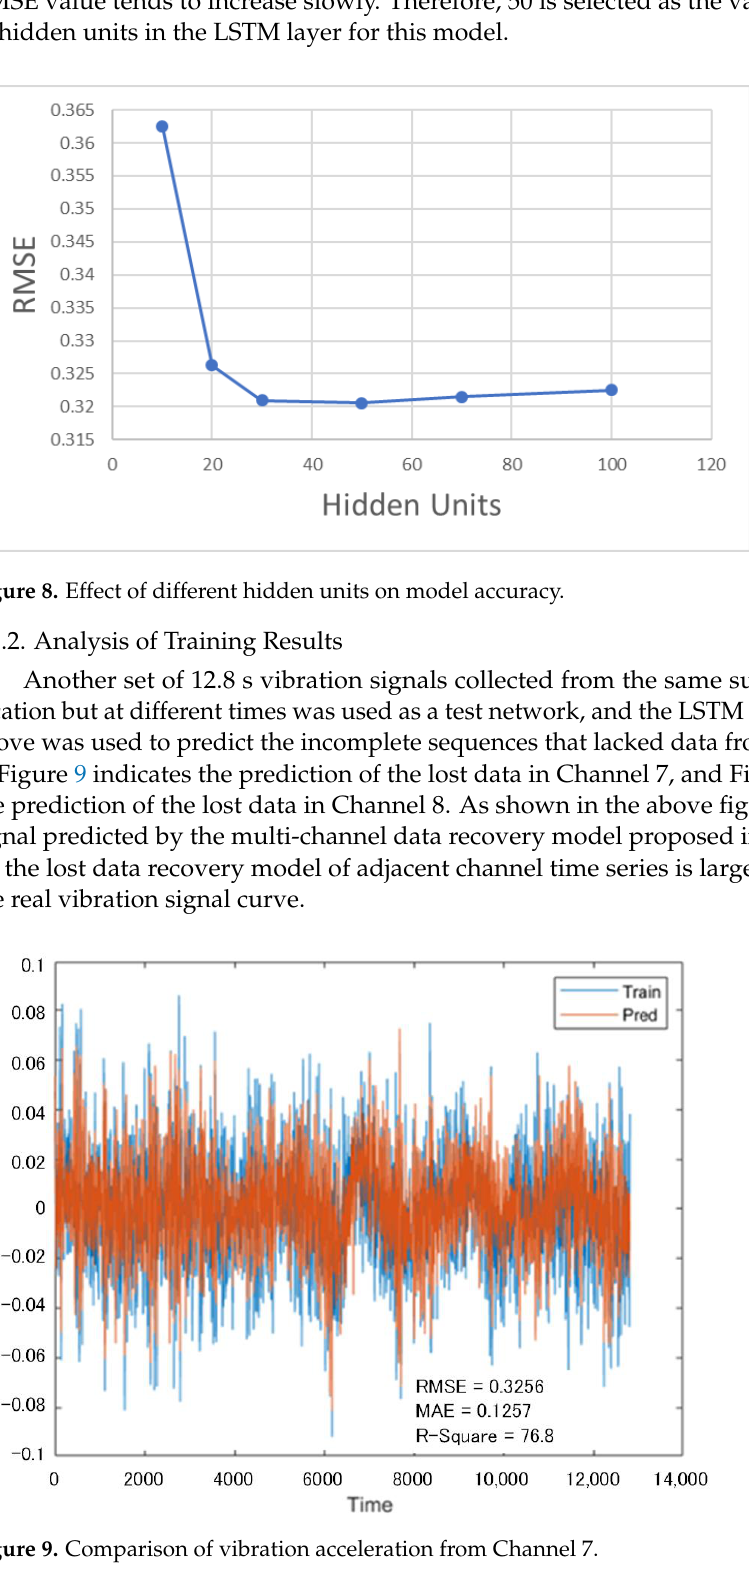
Figure 10. Comparison of vibration acceleration from Channel 8. The vibration acceleration signal is further wavelet-transformed to obtain a more in- tuitive time-frequency image of Channel 7’s vibration acceleration frequency over time. Figure 11 shows the wavelet-transformed time-frequency image of the measured value, and Figure 12 shows the wavelet-transformed time-frequency image of the predicted value. It can be seen from the figures that the change trend in signal frequency of the missing data’s predicted value and measured value over time is largely the same, and that the peak frequency appears at approximately the same position.